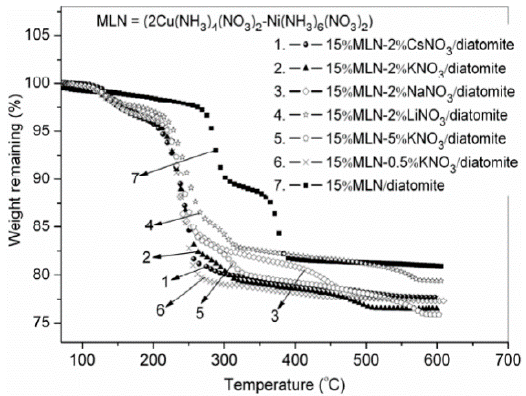
Figure 2. Thermogravimetric analysis (TGA) traces of catalyst precursor.